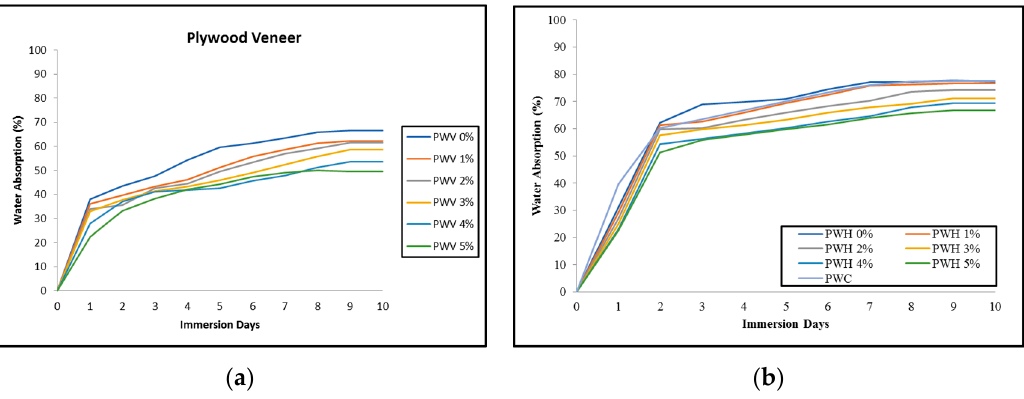
Figure 5. a ) Water absorption (%) of PWV and b ) water absorption (%) of PWH with different Figure 5. ( a ) Water absorption (%) of PWV and ( b ) water absorption (%) of PWH with di ff erent loading loading of PF filled OPA nanoparticles. of PF filled OPA